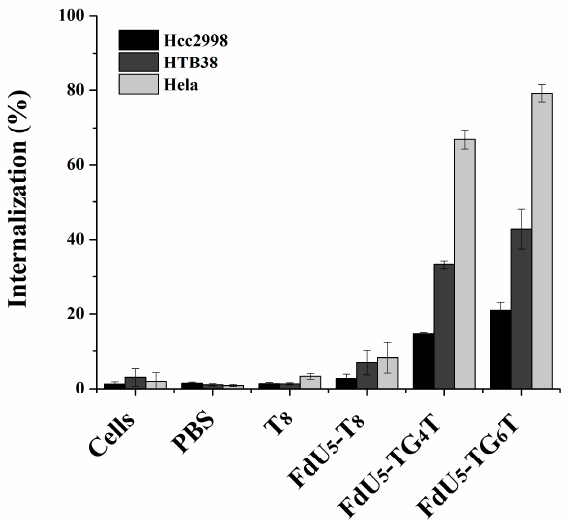
Figure 2. Intracellular uptake of G-quadruplex nanostructures HeLa, and two colorectal cancer cells (HCC2998 and HTB38). Cells were incubated separately with the native and modified G-quadruplexes at 1 µM concentration, and the internalization is shown in the bar graphs HCC2998 (black), HTB38 (dark grey) and HeLa (light grey). Error bars represent the standard deviation (SD) of two independent experiments in duplicate.